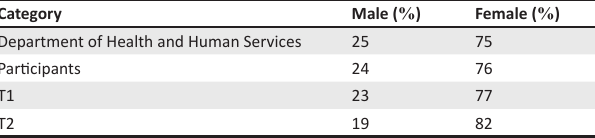
TABLE 2: Gender of the Tasmanian Department of Health and Human Services staff, participants. Category